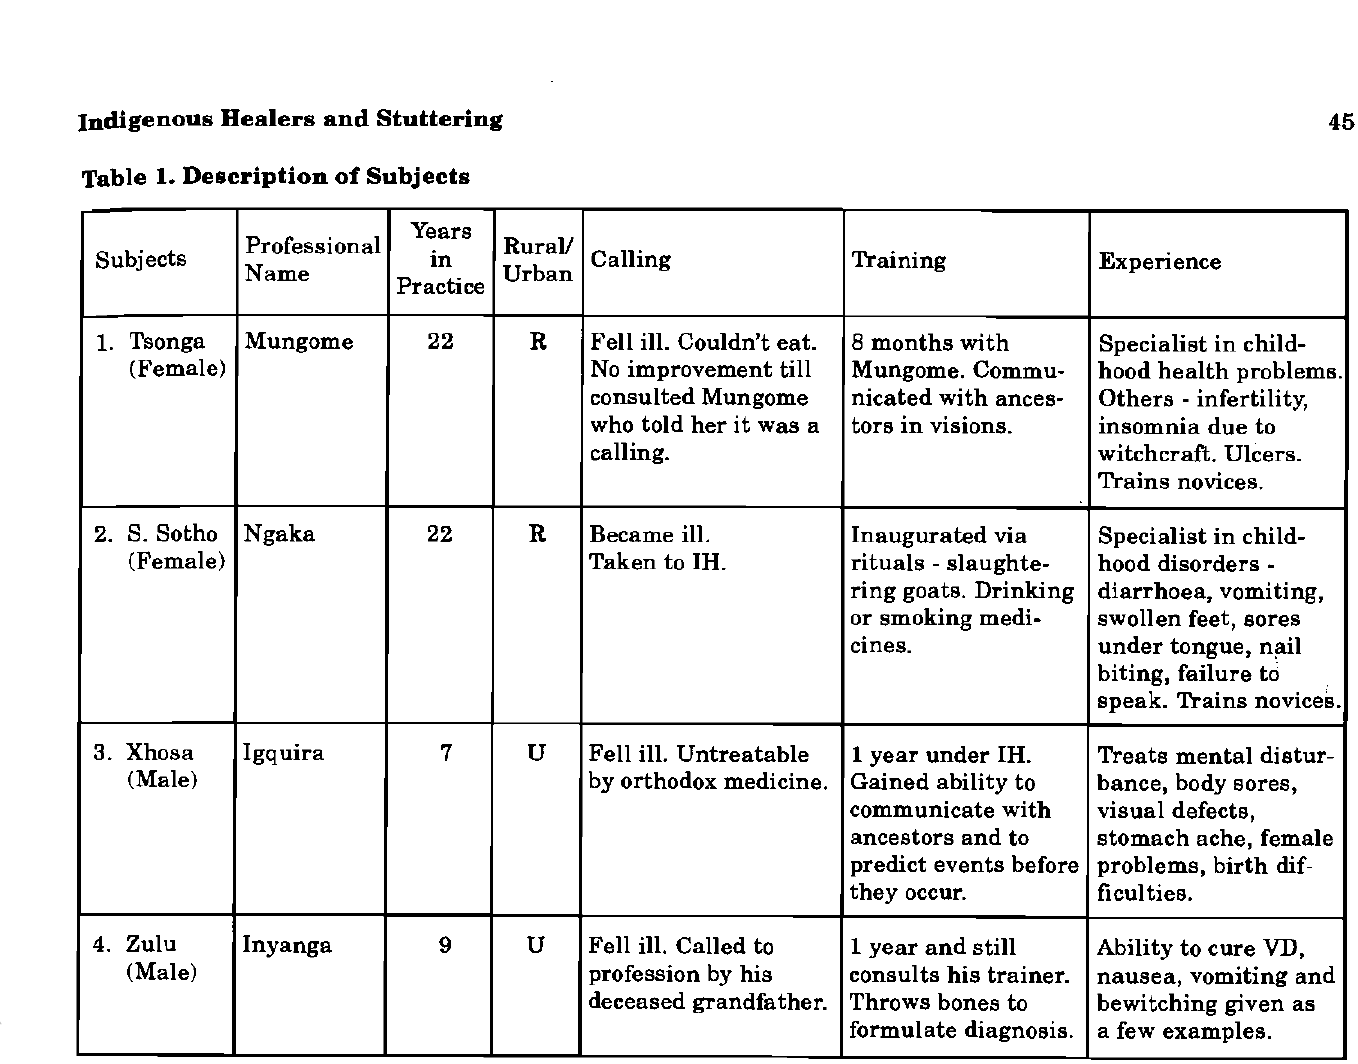
Table 1. Description of